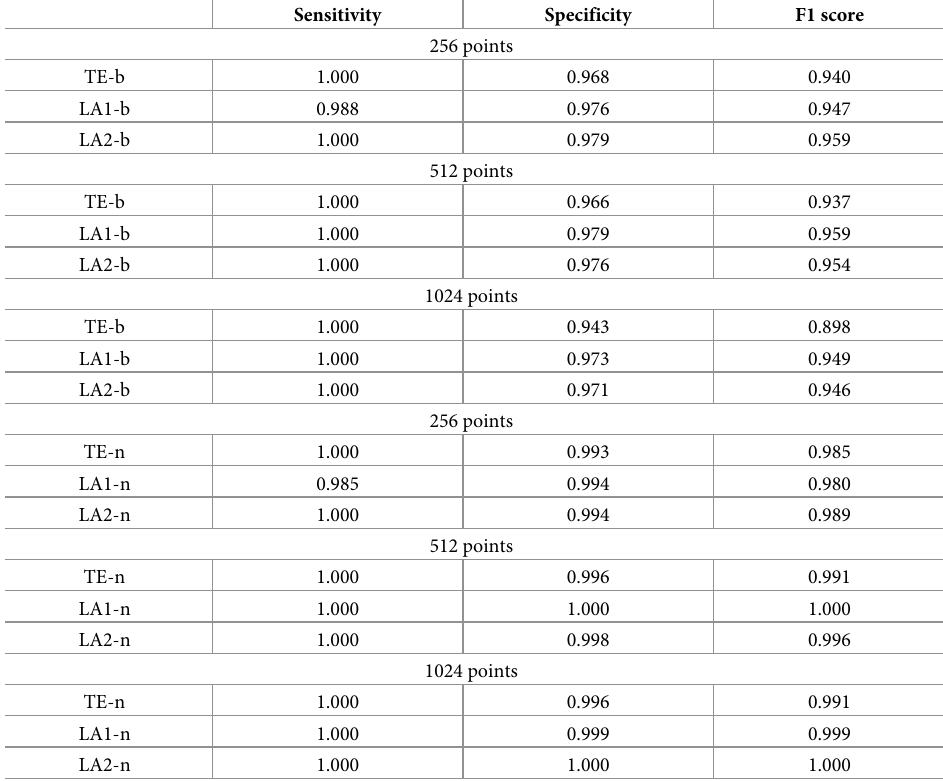
Table 5. Sensitivity, specificity and F1 score values obtained from Model E by binning(-b) and NN(-n)